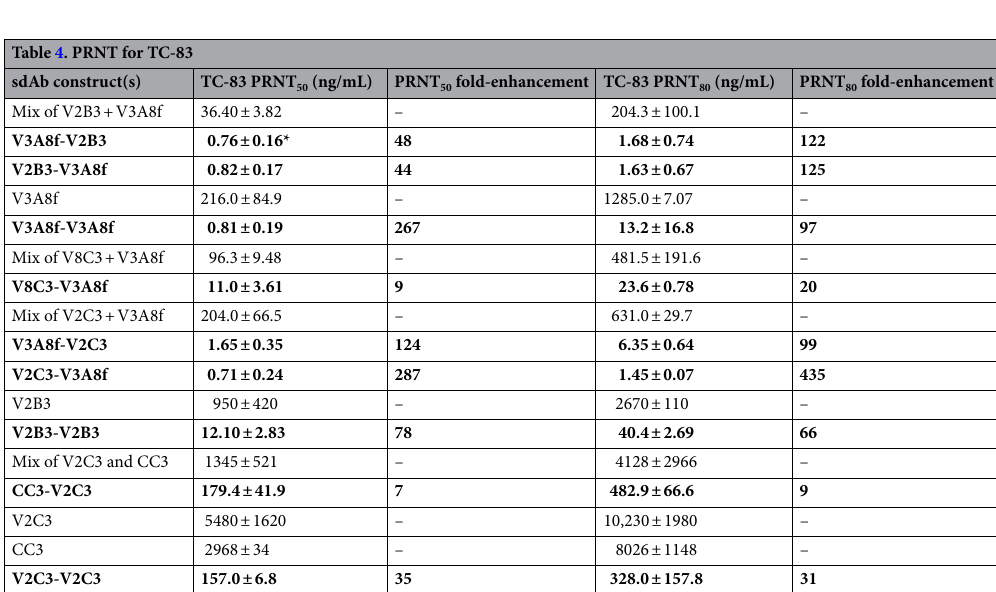
Table 4. Neutralization of VEEV by standard sdAb or linked- sdAb (bold). *STDEV.